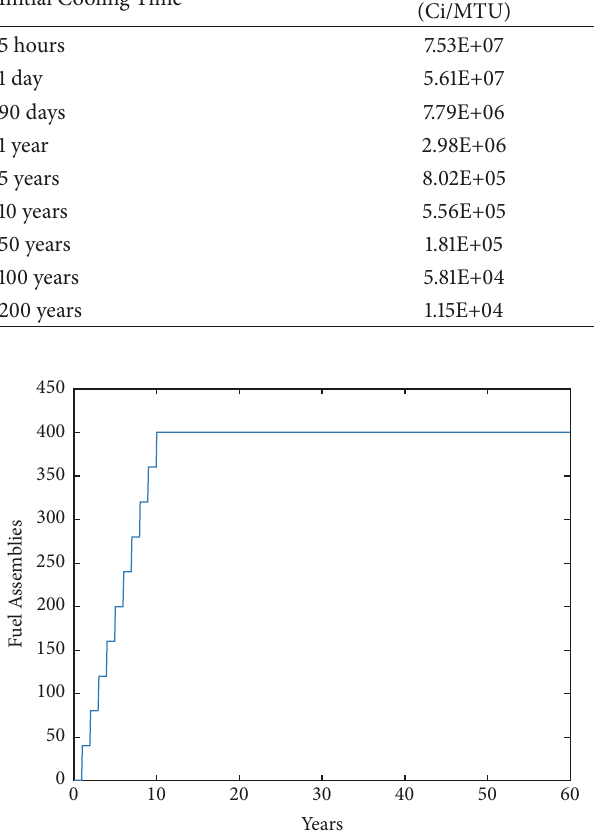
Figure 7: Spent fuel pool occupation for an optimal initial cooling time of 121 months and dose rate limit of 4